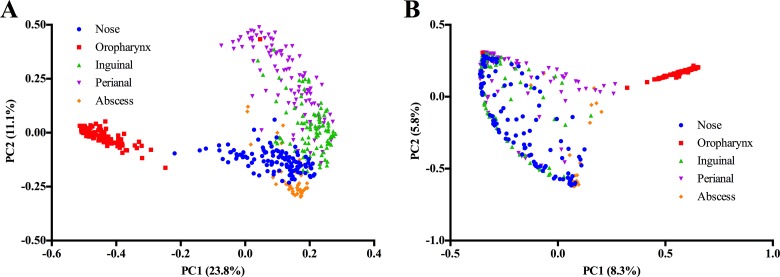
Principal-coordinate analysis (PCoA) showing the variation in body site microbiomes as determined using the Jaccard (A) and ΘYC (B) diversity calculators. Each colored symbol corresponds to an individual sample. The variation represented by each axis (PC1 or PC2) is shown in parentheses.